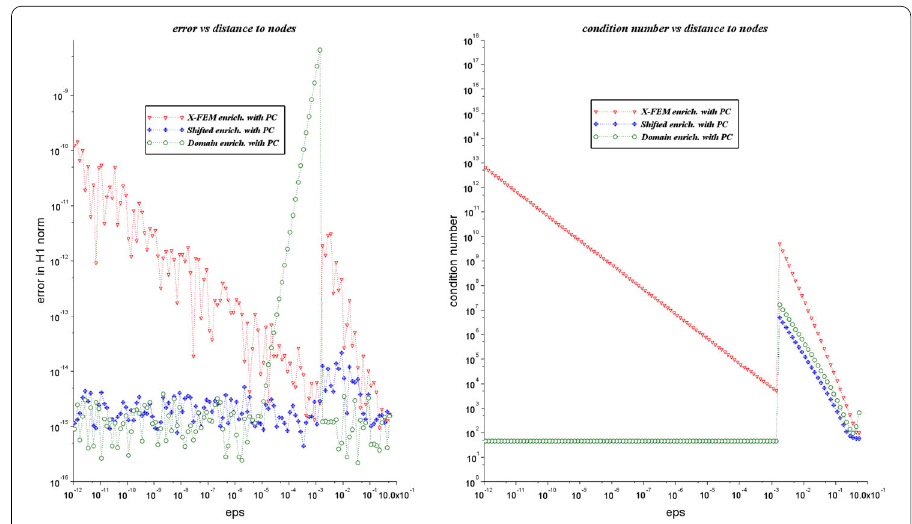
Fig. 28 H1-error with quadratic Lagrange polynomials. The enrichments are alternated through the removal of the middle node beyond a threshold eps of ε = 10 −